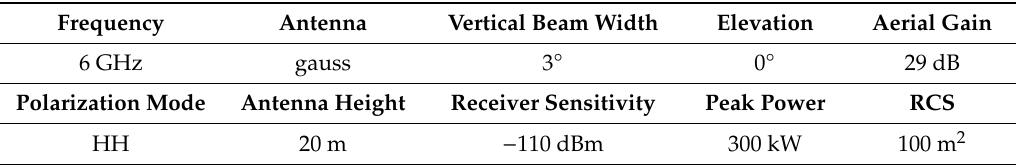
Table 2. Radar signal